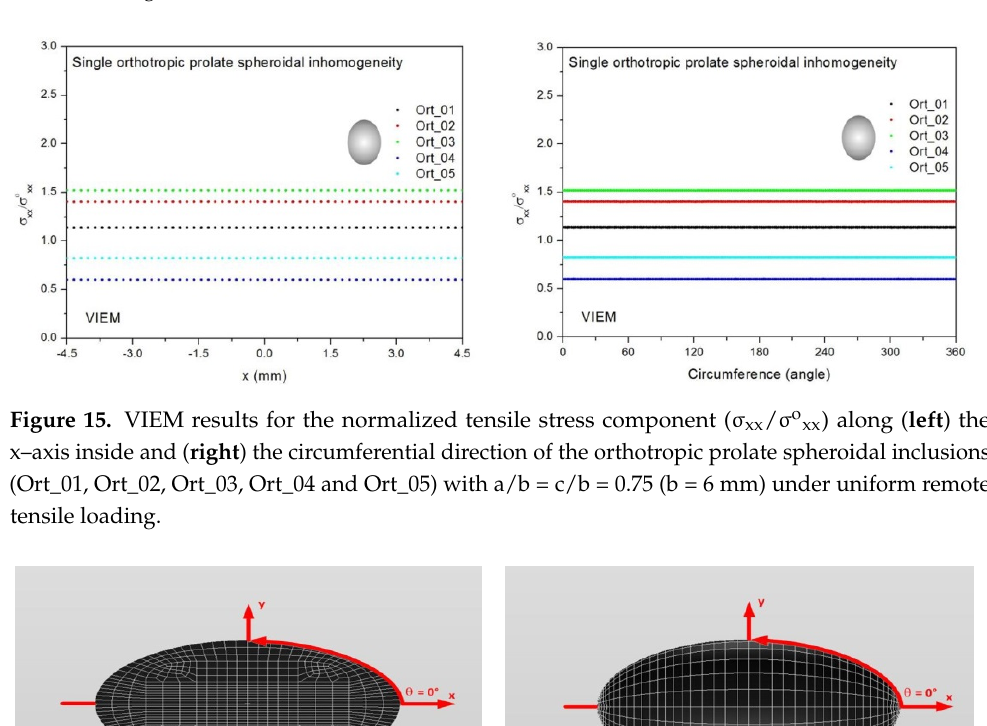
Figure 15. VIEM results for the normalized tensile stress component ( σ xx / σ oxx ) along ( left ) the x–axis inside and ( right ) the circumferential direction of the orthotropic prolate spheroidal inclusions (Ort_01, Ort_02, Ort_03, Ort_04 and Ort_05) with a/b = c/b = 0.75 (b = 6 mm) under uniform remote tensile loading.